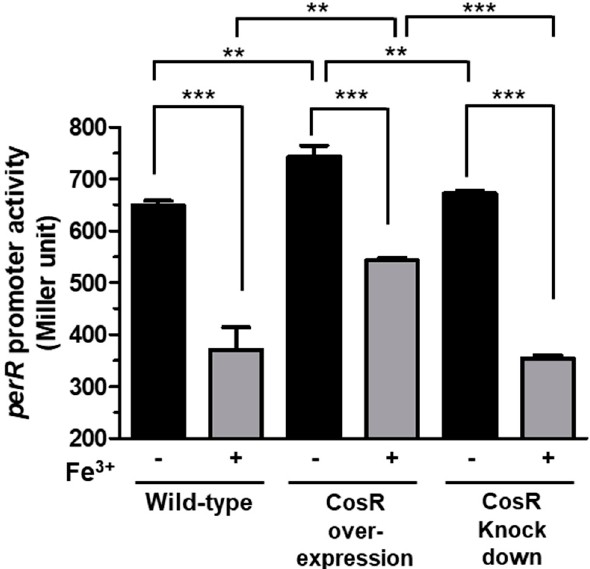
Figure 4. Positive regulation of perR transcription by CosR. The P perR :: lacZ fusion assays were conducted under conditions with different levels of CosR, including wild-type, CosR overexpression, and CosR knockdown using antisense PNA. The experiment was repeated three times, and similar results were obtained in the experiments. The statistical analysis was performed using Student’s t - test. **: p < 0.01, ***: p < 0.001.